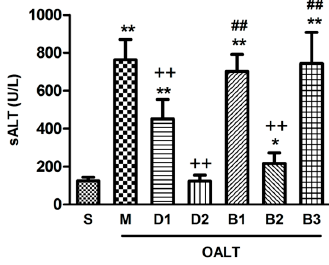
Figure 3. Serum alanine aminotransferase (sALT, U/L) level. The data are expressed as the means ± SD ( n = 6–7). * p < 0.05, ** p < 0.01, vs. group S; ++ p < 0.01, vs. group M; ## p < 0.01, vs. group